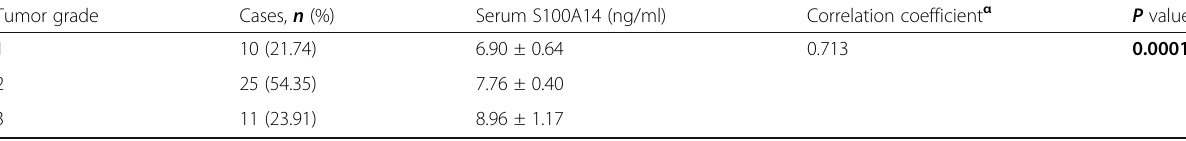
Table 2 Correlation between S100A14 serum level and breast cancer tumor grade Tumor